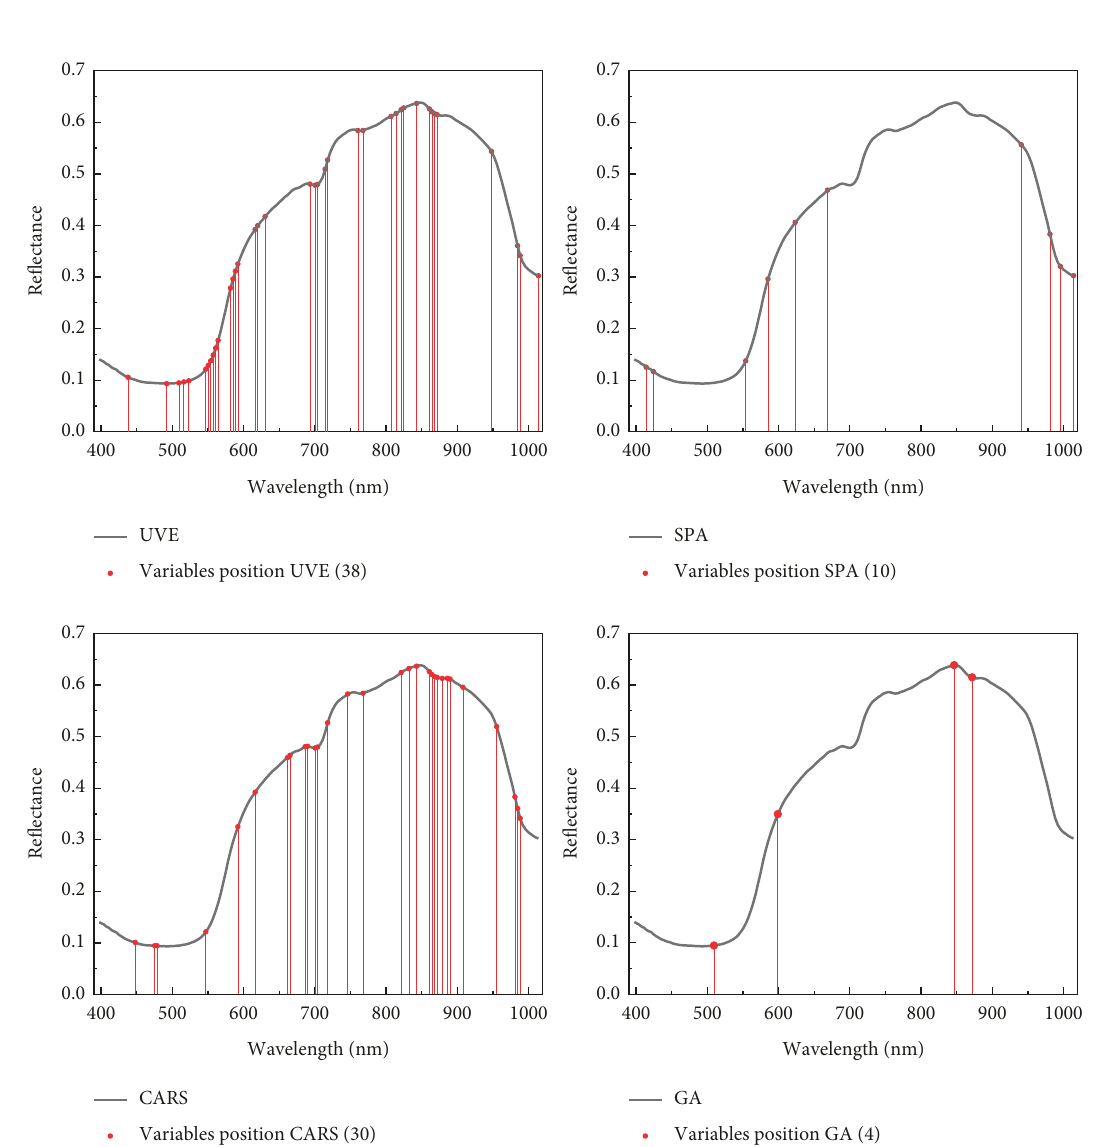
Figure 6: The location of the reflectance spectra characteristic wavelengths was selected by UVE, SPA, CARS, and